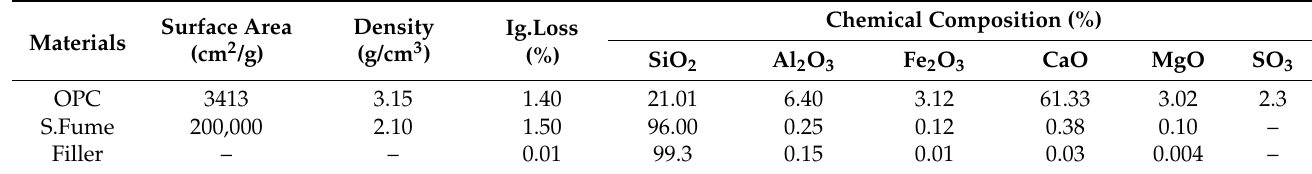
Table 1. Mechanical and chemical characteristics for UHPC.